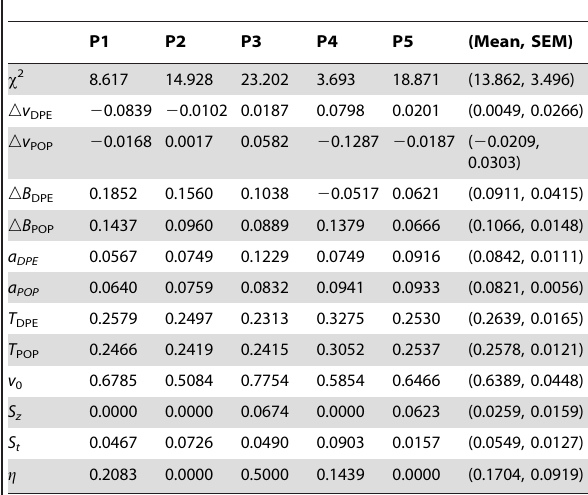
Table 2. Best-Fit Parameters of Full